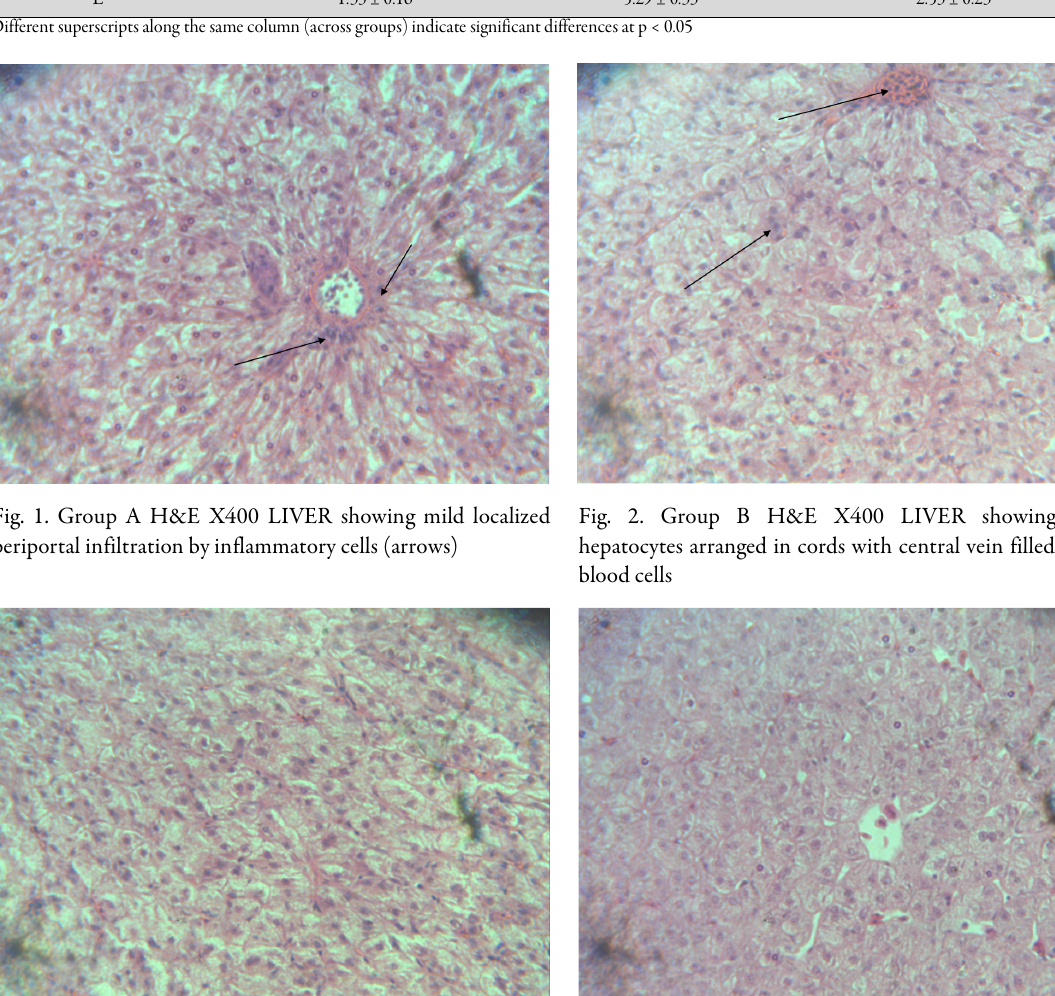
Fig. 3. Group C H&E X 200 LIVER showing normal liver architecture